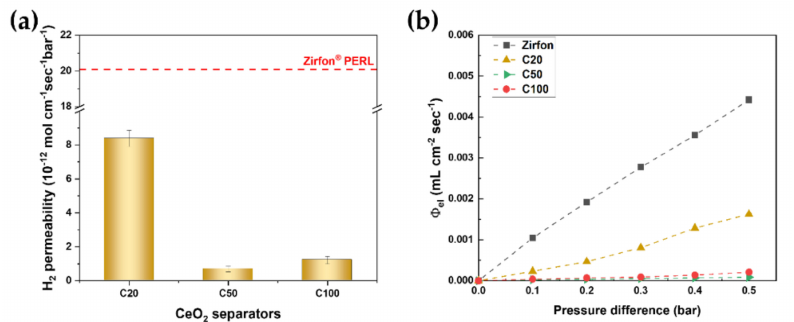
Figure 4. ( a ) H 2 permeability ( b ) volumetric permeation flux density of the composite separators and Zirfon.